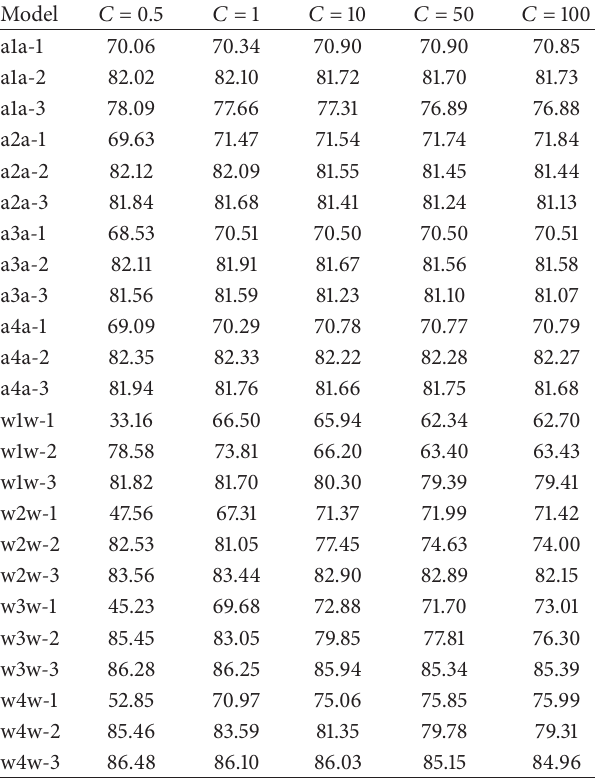
Table 4: Systematic F -measure at different parameter values (%). Model